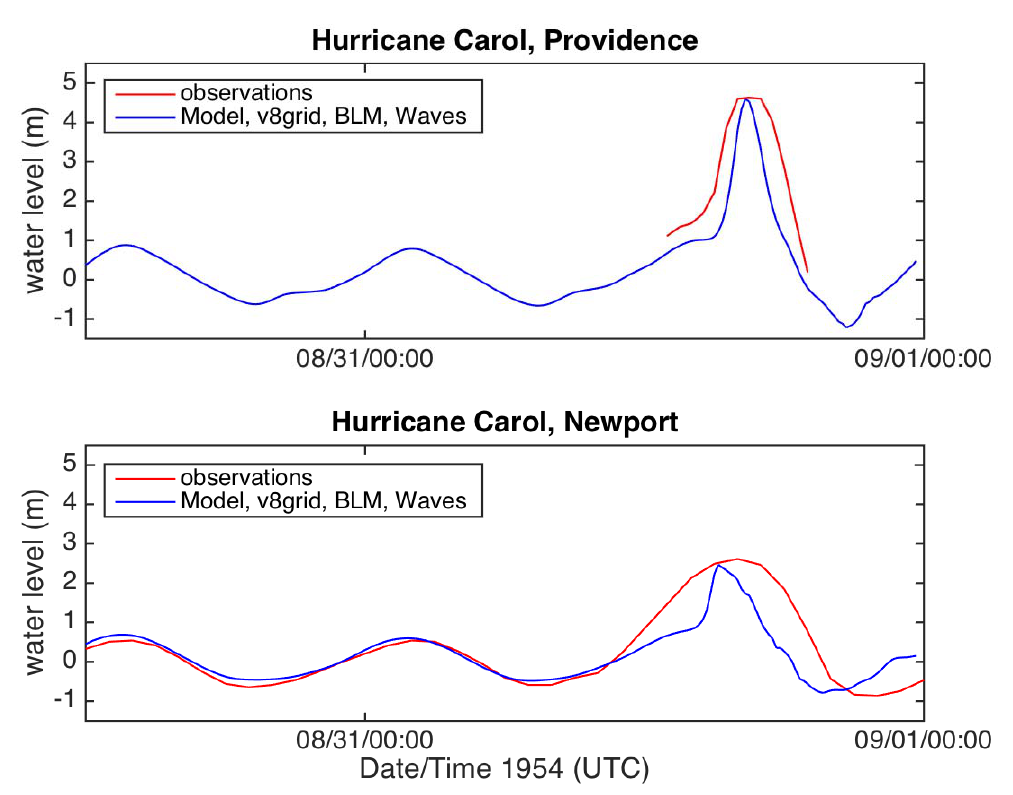
Figure 5. Time series of water level at Providence ( top ) and Newport ( bottom ) during Hurricane Carol. Observations are shown in red and model output is denoted by the blue lines. Image: Authors.